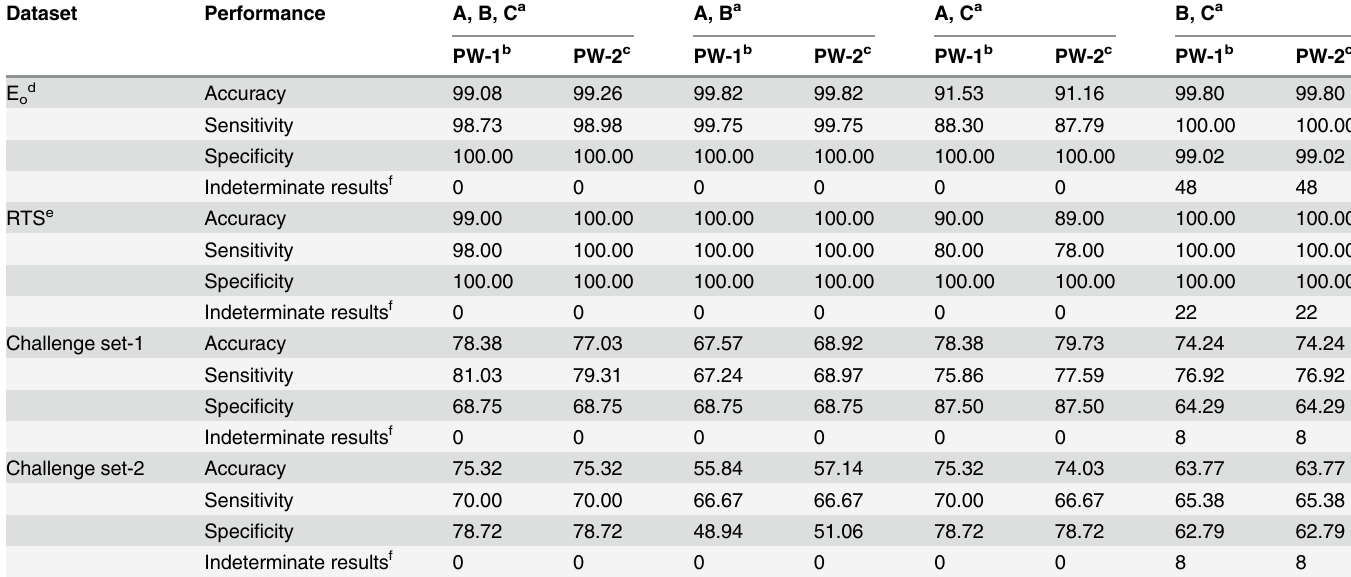
Table 4. Leave-one out analysis to assess the contributions of QSAR models, similarity information and sub-structure pattern to the prediction performance of prediction workflows.